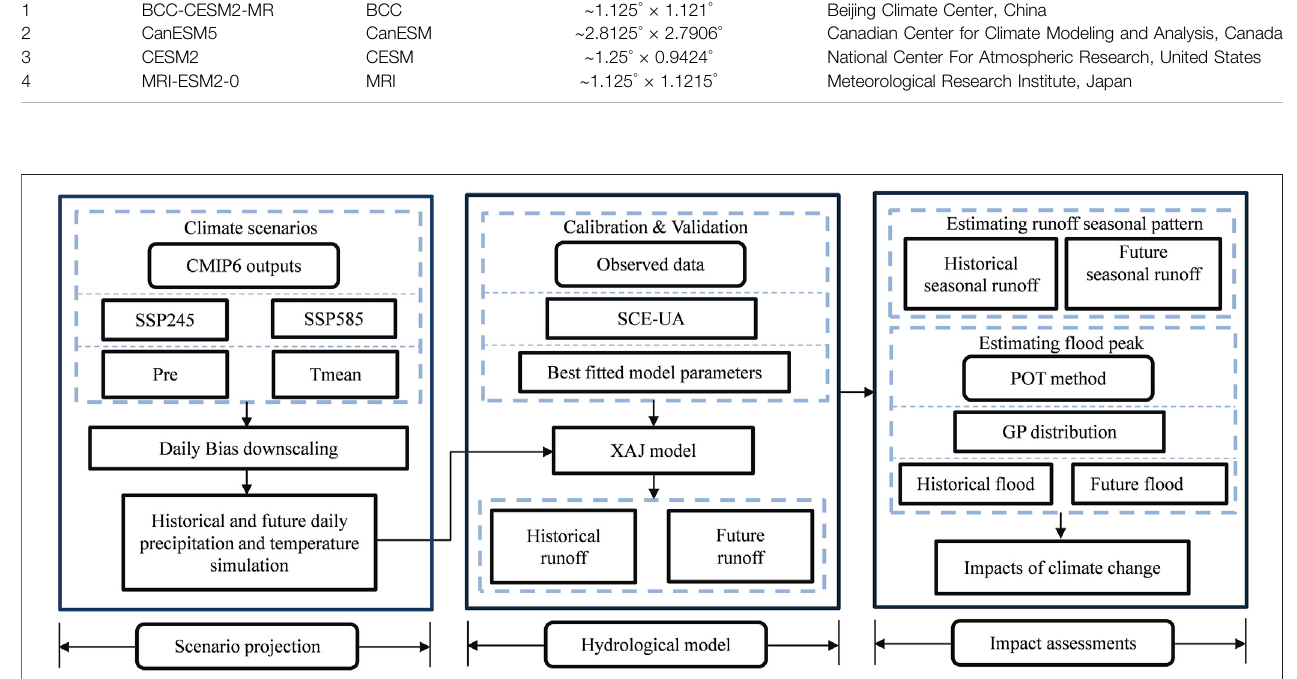
FIGURE 2 | Methodology framework of future climate change impacts on seasonal runoff pattern and fl ood characteristics in the Xixian basin.